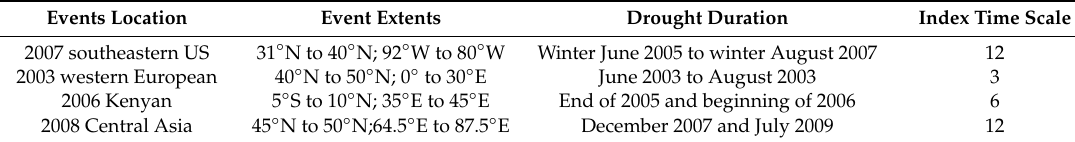
Table 5. Information of the five drought events analyzed in this